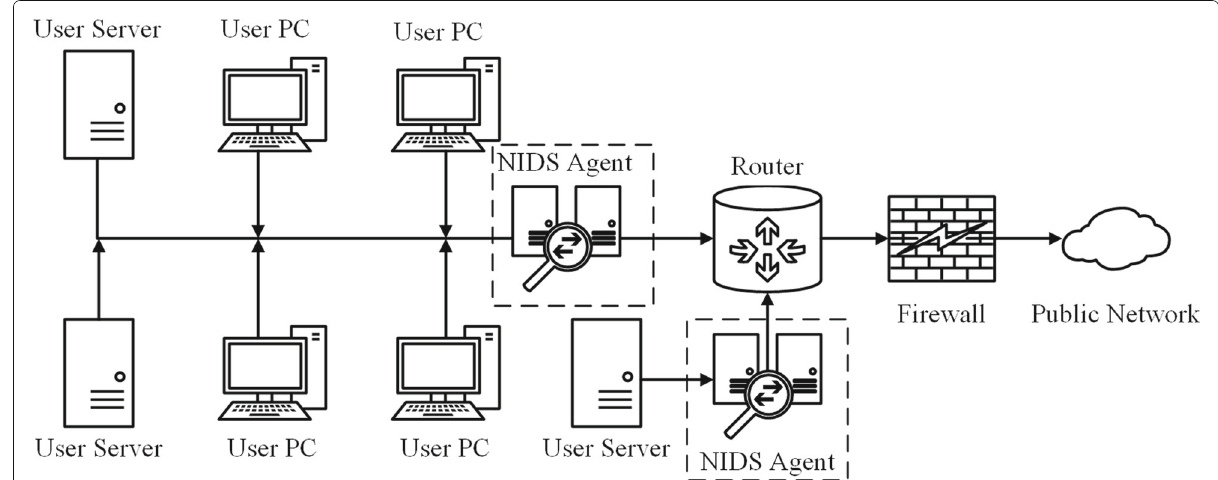
Fig. 7 Generic architecture of a network-based IDS (NIDS). The operational structure of a NIDS and its location in the